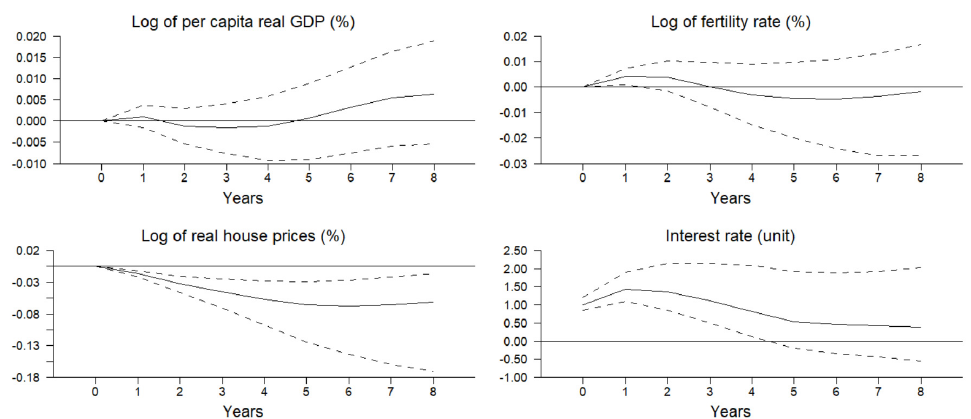
Figure 7. Responses to an interest rate shock in the baseline structural VAR when the Shiller home price index is replaced by the all-transactions house price index in the model.